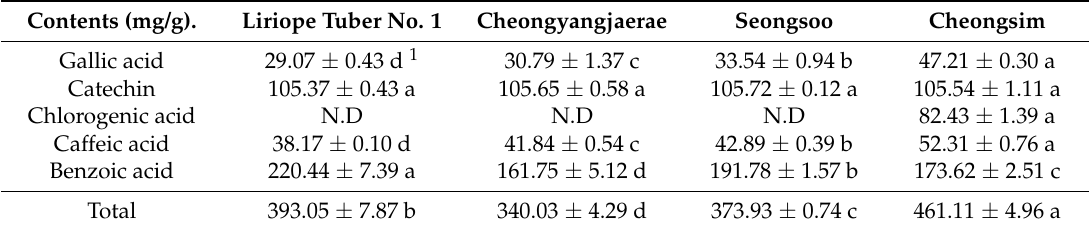
Table 2. Phenolic compounds ( µ g/g dry weight) in different cultivars of L. platyphylla. Contents